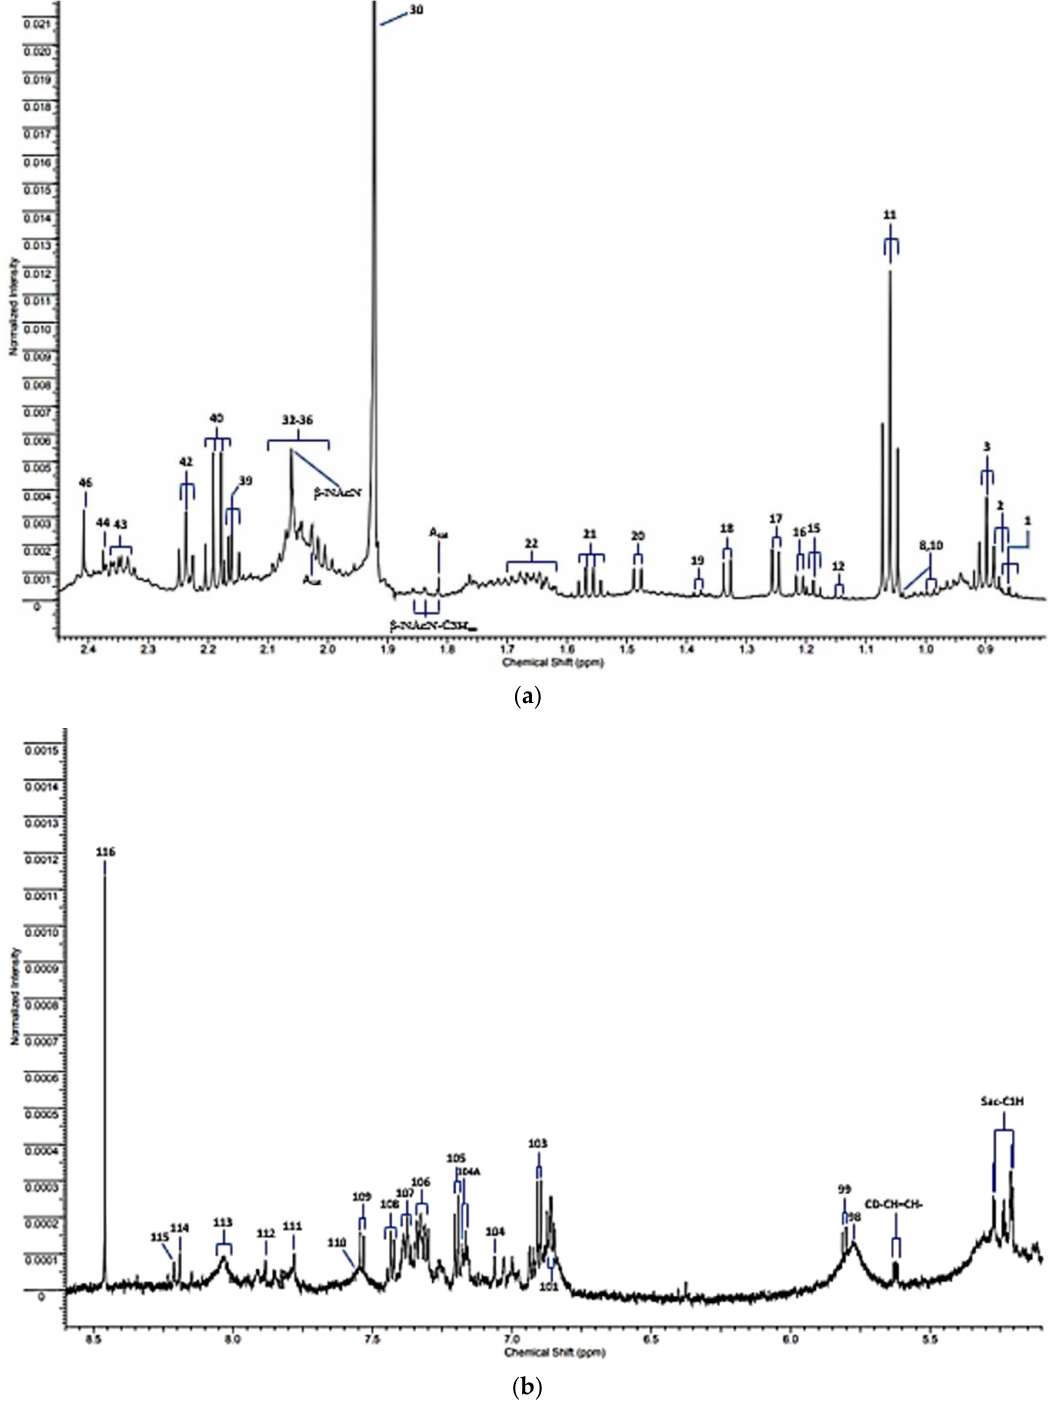
Figure 1. Partial 1 H NMR profiles of a WMSS sample provided by a healthy human participant, stored and prepared for analysis according to our protocols described in [1]. ( a , b ) 0.80–2.45 and 5.10–8.60 ppm regions of spectra acquired, respectively. Typical spectra are shown. Abbreviations: Assignment labels correspond to those available in Table 1; some tentative assignments are also indicated, as are unassigned signals. Single-pulse noesy-presat 1 H NMR spectra were recorded on a Bruker Avance-600 spectrometer operating at frequency of 600.13 MHz and a probe temperature of 293 K. The highly intense H 2 O/HOD resonance ( δ = 4.80 ppm) was subdued with radiofrequency pulse presaturation. Pulsing conditions were: sweep width 8389 Hz; 5 µs pulses; 1.0 s pulse repetition rate; 32,768 (then zero-filled to 65,536) datapoints; 128 transients. An exponential line-broadening function of 0.30 Hz was applied to FIDs before Fourier transformation. Table 1. Assignments of resonances in the 600 MHz 1 H NMR spectra of WMS supernatant samples for the expanded δ = 0.80–2.45 and 5.10–8.60 ppm regions only. Chemical shift (ö) values and resonance coupling patterns are also provided. * Indicates tentative assignment. Resonances and their assignments within the 2.45–5.10 ppm regions of spectra (signals 47–95) are omitted for the purpose of clarity, but these may be viewed in Part I of this series of reports [1]. Assignment Code